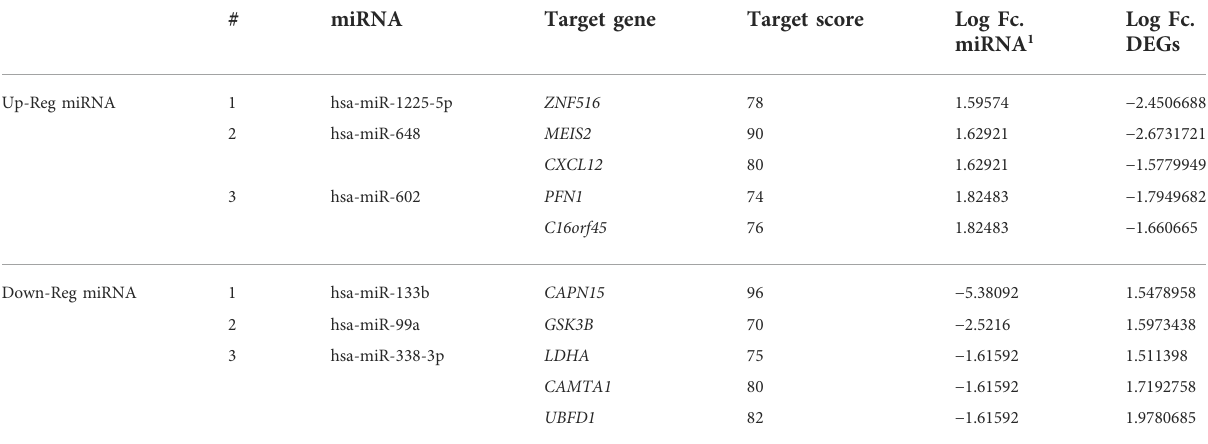
TABLE 2 The top miRNA-target gene pairs of prostate cancer tissues.